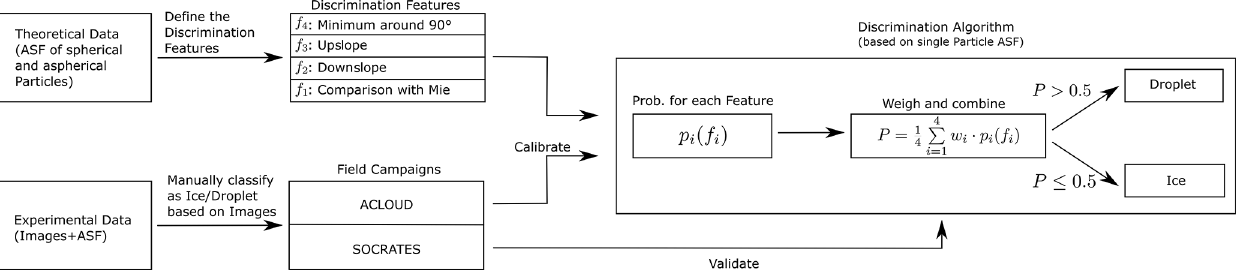
rameter based on two exemplary droplets: a droplet ( d 1) with D = 119.6 µm (the same particle as used in Fig. 2) and a the- oretical Mie sphere ( d 2) with D = 200 µm. Figure 4a shows the ASFs for the two particles as well as the ASF of the ref- erence Mie sphere with D = 100